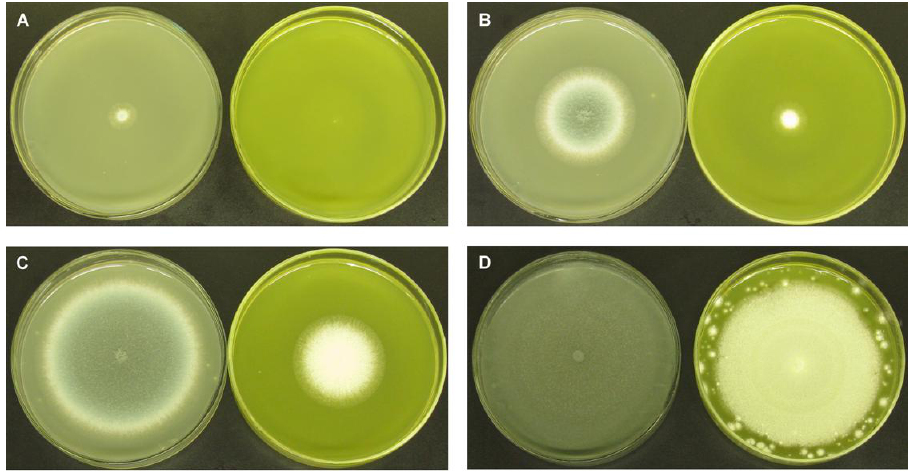
Figure 4. A. fumigatus without (left) and with (right) treatment with BER (at the 1/2 MIC 128 μ g/mL), comparing giant colonies grown on PDA at 35 °C for 3 days ( A ), 5 days ( B ), 7 days ( C ) or 10 days ( D ). Effects of BER on colony size, mycelial growth and conidial pigment were investigated. Images shown are representative of three independent